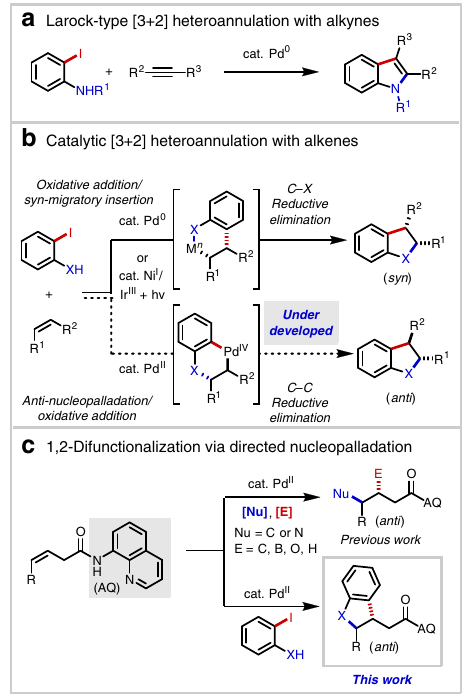
Fig. 1 Background and project synopsis. a Larock-type [3 + 2] heteroannulation with alkynes. b Catalytic [3 + 2] heteroannulation with alkenes. c 1,2-difunctionalization via directed